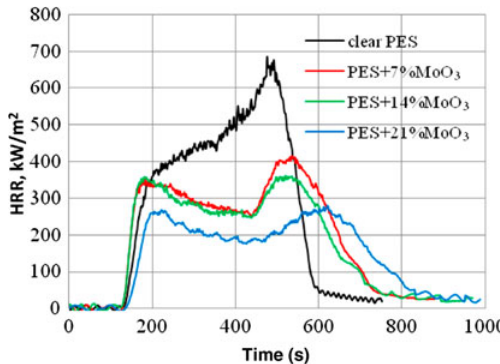
Fig. 2. Heat release rate for polyester material unmodified and modified with MoO 3 at the heat flux density of 30 kW/m 2 on piloted